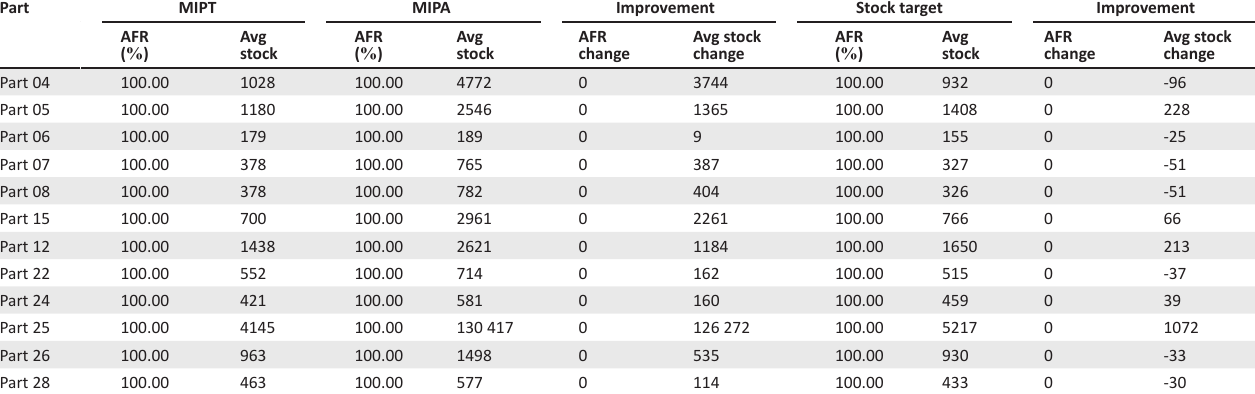
TABLE 4: Results of simulating actual demand data for fast moving import